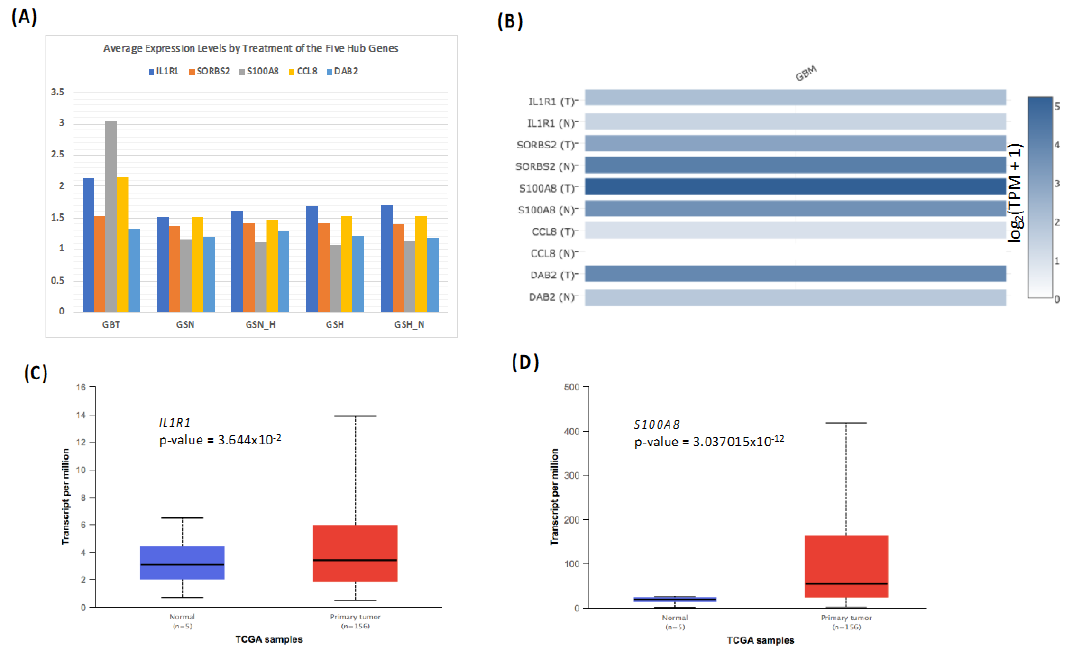
Figure 8. ( A ) Histogram of the five most significant hub gene expression levels by treatments. ( B ) The multiple gene comparison studies of most significant hub genes are plotted on TCGA normal and GTEx datasets. Boxplot showing relative expression of ( C ) IL1R1 and ( D ) S1000A8 in normal ( n = 3) and GBM ( n = 156) samples.